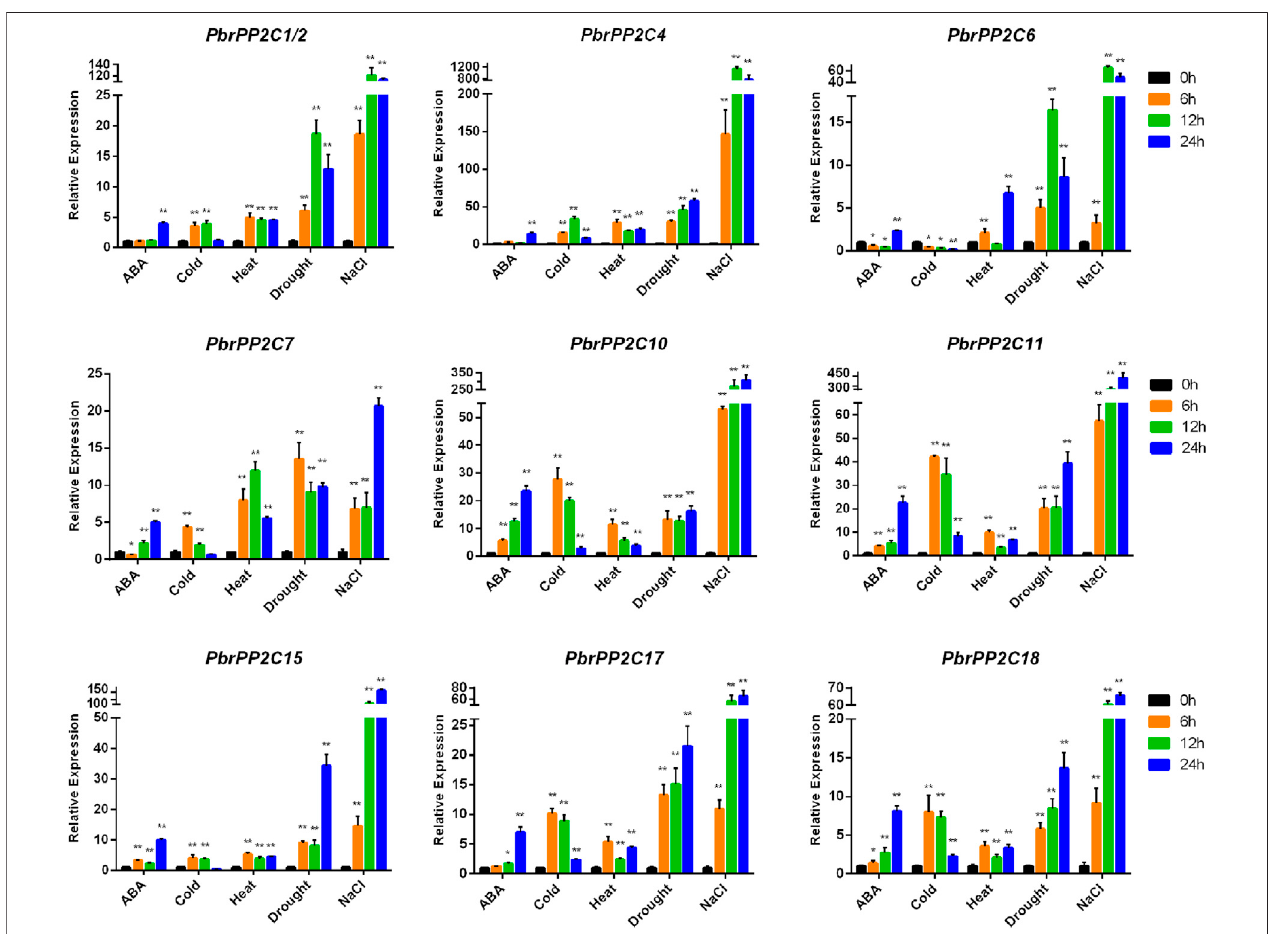
FIGURE 6 | QRT-PCR analysis of subgroup A PbrPP2C genes under exposure to heat, cold, drought, NaCl, and ABA treatments in pear seedlings. Standard errors and ANOVA were calculated by applying Student ’ s t-test. Single and double stars stand for the levels of signi fi cant difference at p -value < 0.05 and < 0.01,